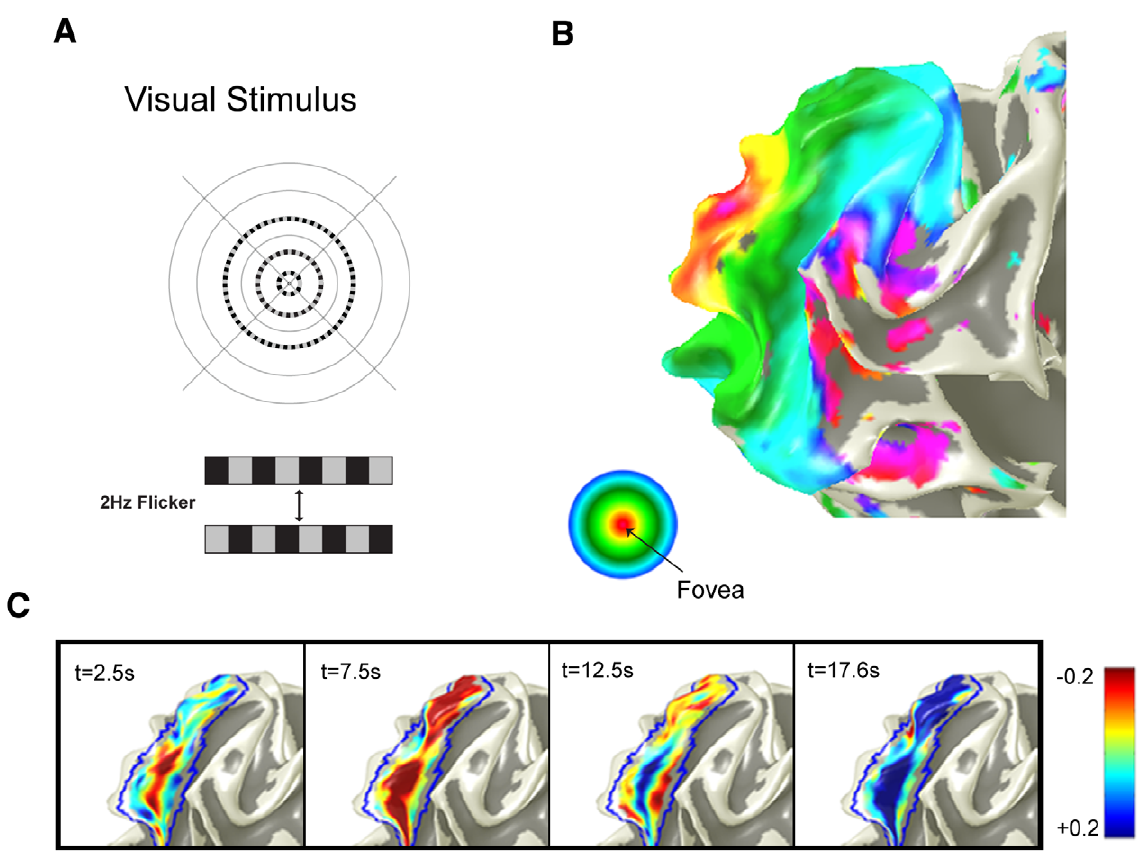
Figure 3. Experimental paradigm and evoked responses. A: The visual stimulus used in the experiment, where it is superposed on a gray background. The solid black circles and cross are always present, to aid fixation. The three dashed isoeccentric rings reverse 4 times per second, where the two patterns are shown at the bottom of this frame. B: Retinotopic mapping the allowed the locations of the 3 concentric rings to be independently identified, where the colors represent the measured eccentricity, colored from red at the fovea to blue at 6 u , as shown in the circular inset, with magenta and gray at larger eccentricities [3]. C: Spatiotemporal snapshots showing the response to first ring at various times after stimulus onset. The colors represent percentage signal change, as labeled on the colorbar.